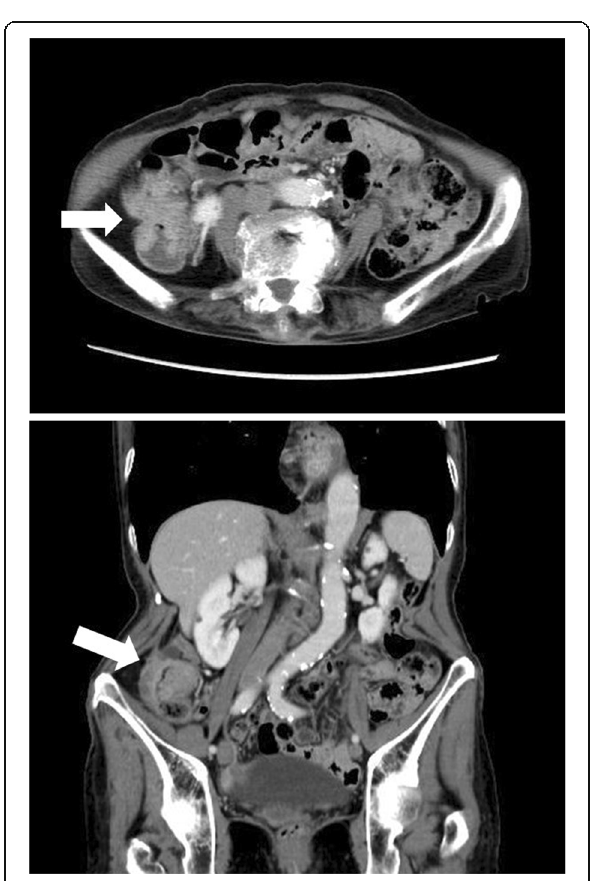
Fig. 2 CT: the wall thickness of the ascending colon was